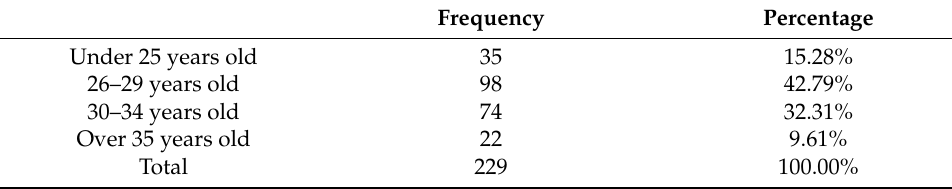
Table 2. Age ranges of the respondents.